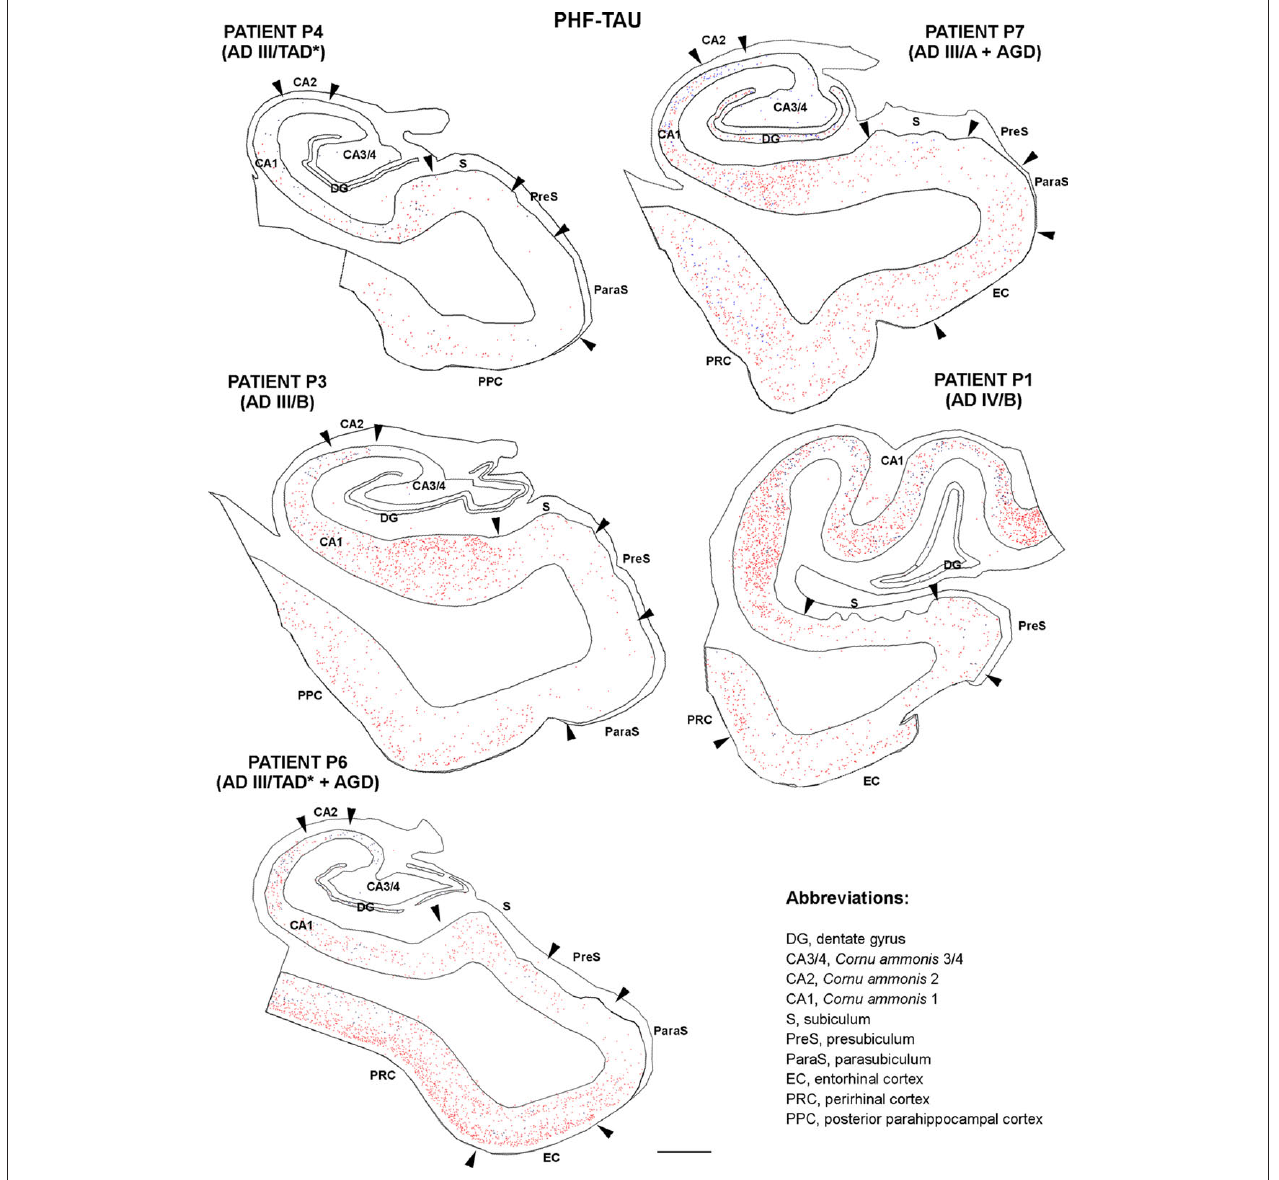
and adjacent cortex from AD cases. Borders between the different cytoarchitectonic regions are indicated by arrowheads. Scale bar: 1,000